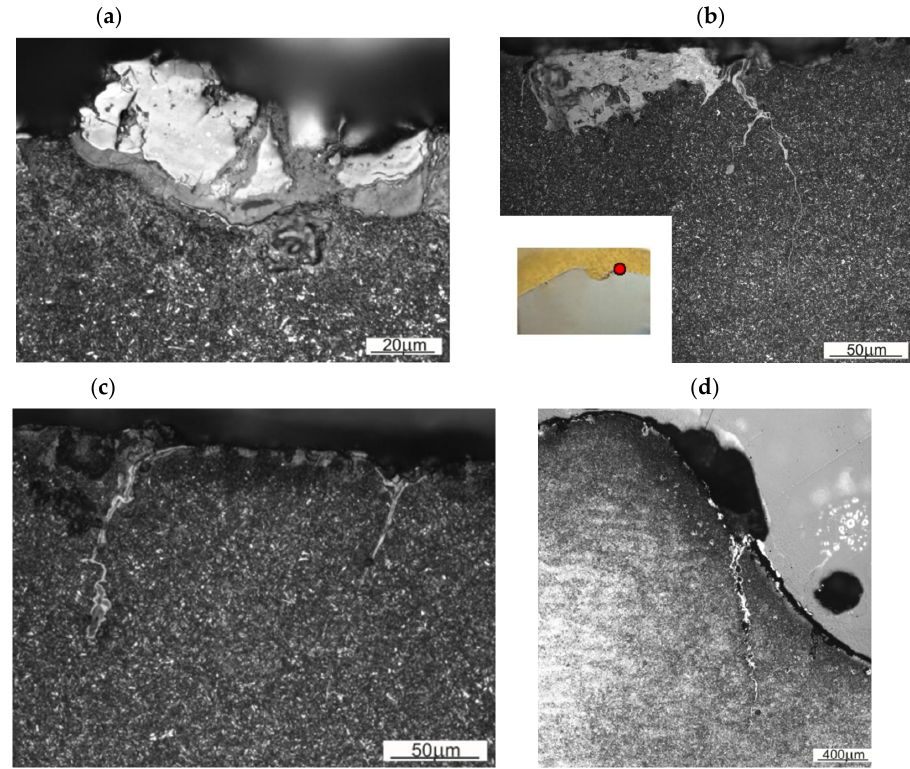
Figure 12. Changes in the die surface layer: ( a ) multilayer oxidation products, ( b ) the effect of fatigue-corrosion crack initiation near the area of intense oxidation of the surface layer of finishing die cavity (shown in b —die cavity on the right side; red dot indicates the area of metallographic observations.) for forging wound spreader components, ( c ) microcracks that are the nucleus of further fatigue-corrosion cracking, ( d ) a crack in the area of the edge of the die cavity from the center of the die.